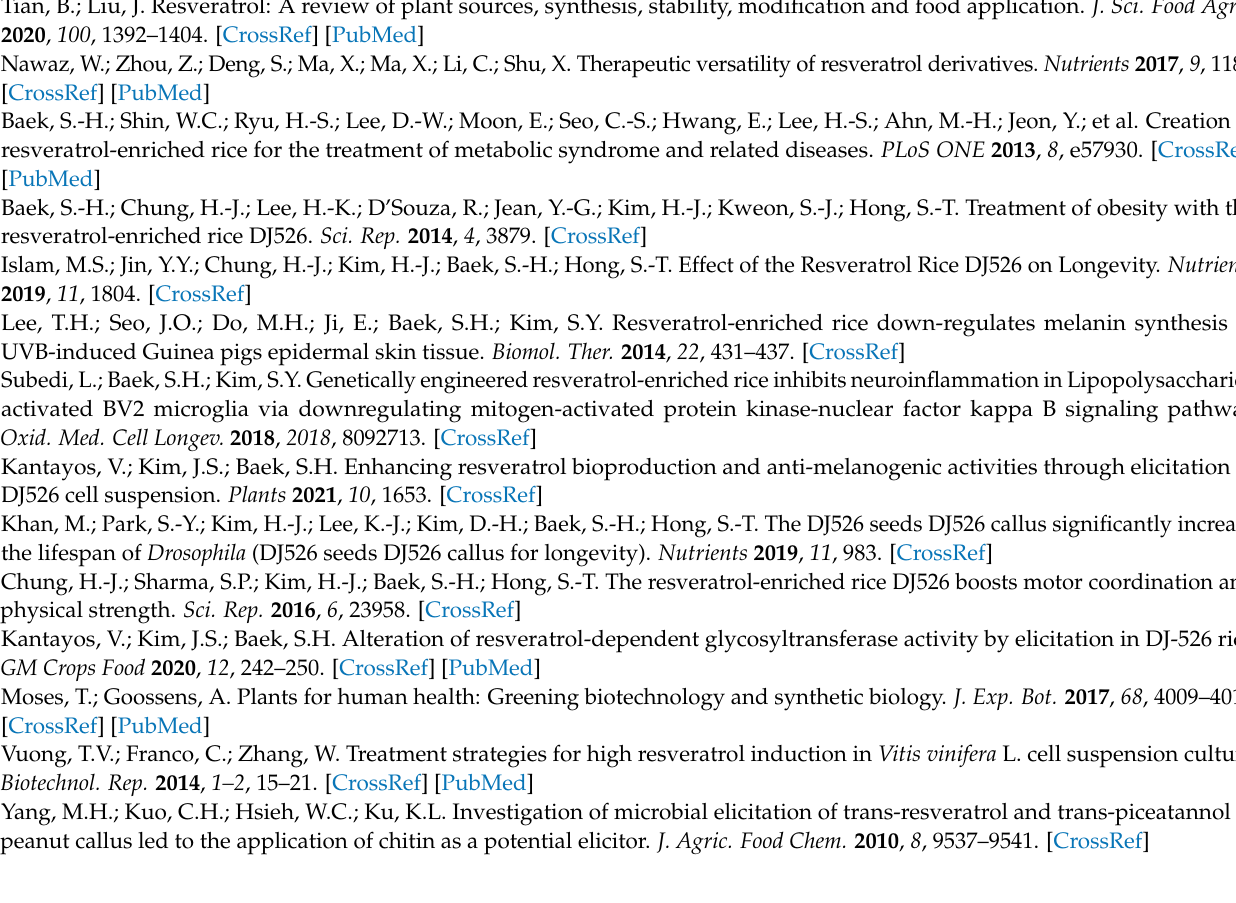
Figure S2: Calibration curve of vitamin C at concentration 0.0039065 to 0.25